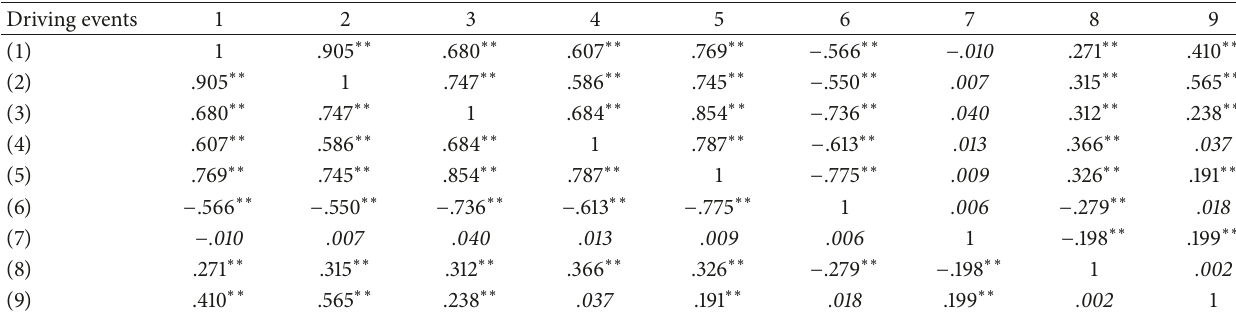
Table 3: Correlation between arguments.